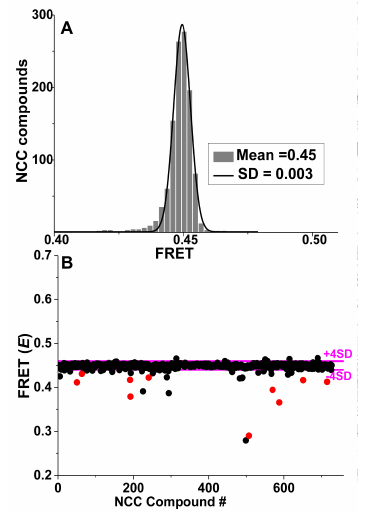
Figure 5. Time-resolved fluorescence resonance energy transfer (TR-FRET) based HTS of National clinical collection (NCC) library for compounds that modulate actin-ANT FRET. ( A ) Histogram plots of all NCC library compounds after removal of fluorescent compounds show an average FRET efficiency of 0.45 ± 0.003. ( B ) FRET from a representative NCC screen with “Hit” threshold (>4 SD of mean) indicated by magenta lines. Reproducible “Hits” from triplicate screens are shown in red. Adapted